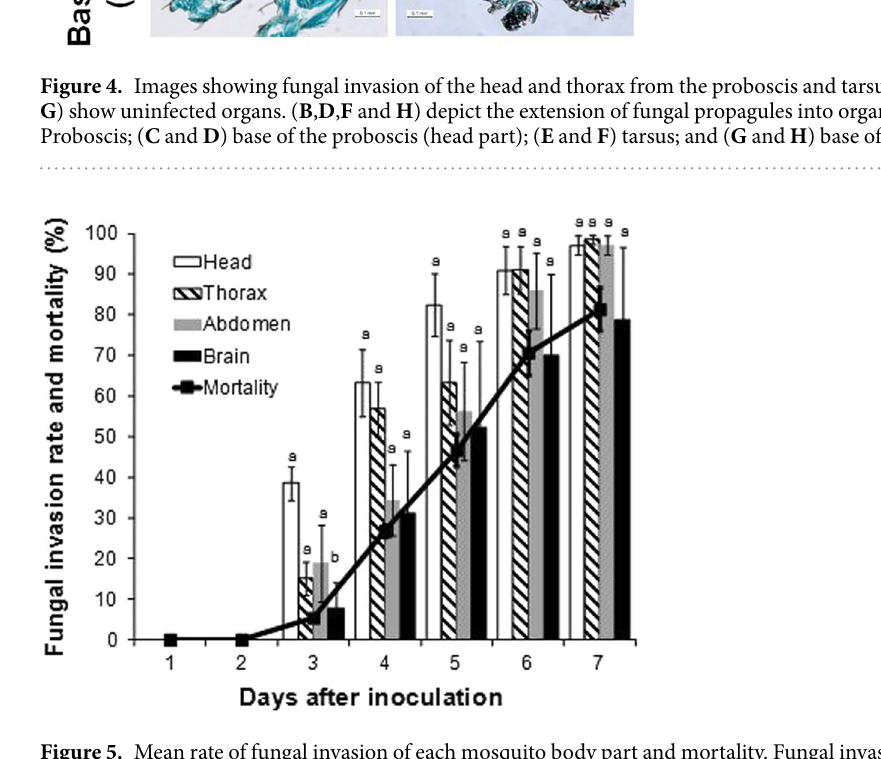
Certain pathogens tend to preferentially infect the head part of a host, including the brain and/or the central nervous system (CNS). Baculovirus was reported to affect the host brain by using a protein tyrosine